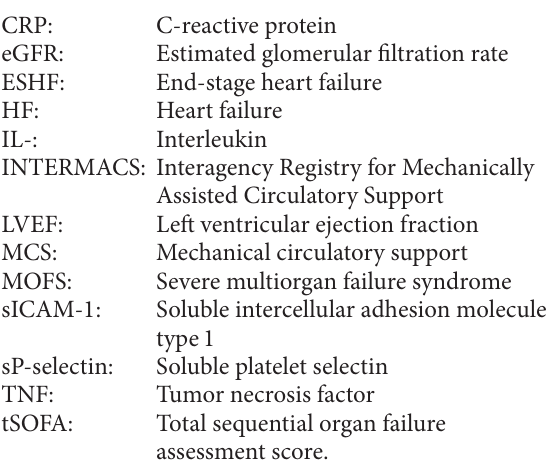
Figure 5: (a) The area under the curve of TNF- 𝛼 and (b) IL-8 levels from 4 hours at 1 week after intervention (AUC 164 experienced postoperative maximal tSOFA score < 11 (group A: empty box-plots), and patients with postoperative maximal tSOFA score ≥ 11, with positive (group B: light gray box-plots) or negative (group C: dark gray box-plots) 3-month outcome. 𝑃 values are for differences among groups by Kruskall-Wallis text. ∗ 𝑃 < 0.05 versus group A by Mann-Whitney text corrected by Bonferroni. ∘ 𝑃 < 0.05 versus group B by Mann-Whitney text corrected by